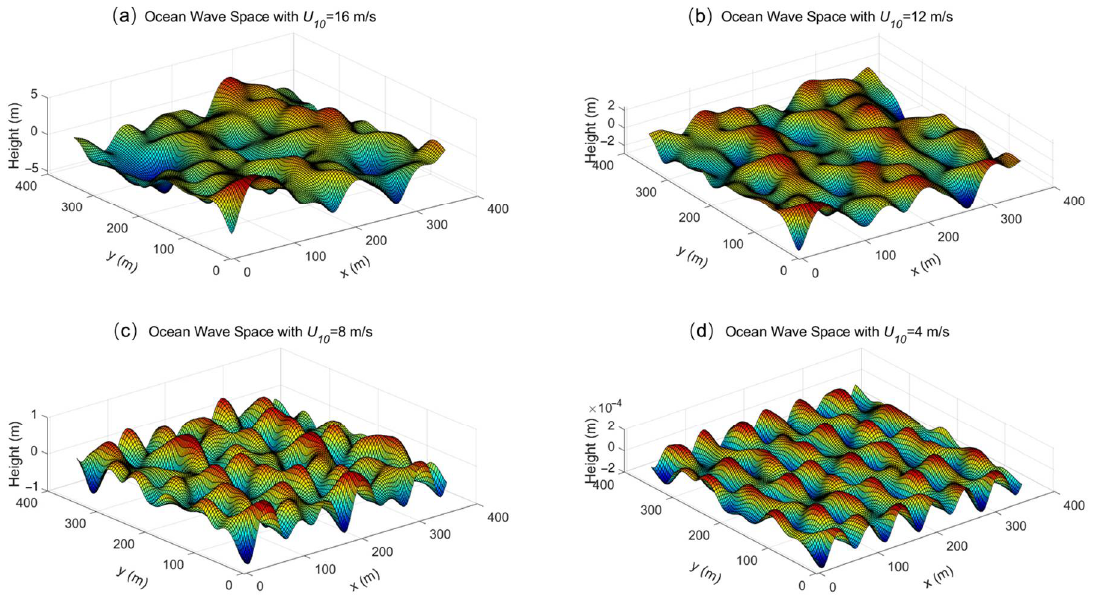
Figure 9. The 3D sea surface simulation figure with different wind speeds of ( a ) U = 16 m/s; ( b ) U = 12 m/s; ( c ) U = 8 m/s; ( d ) U = 4 m/s.